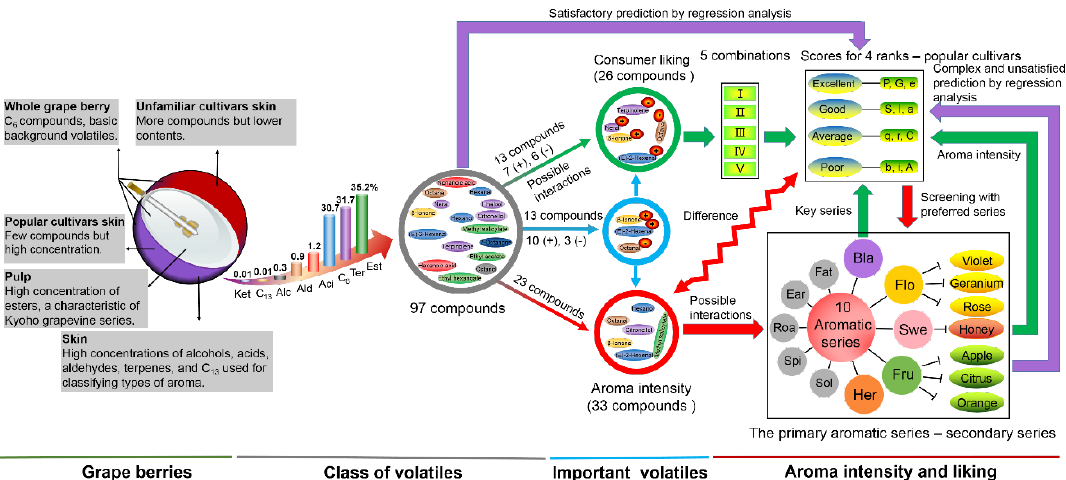
Figure 7. Schematic diagram showing the overall aroma characteristics of table grapes from a chemical perspective. The chemical types and primary aromatic series are represented by the first three letters of their names. Column heights indicate the average content of each chemical type, and for convenient viewing, the column heights of five volatiles (alcohols, acids, aldehydes, ketones, and C 13 -norisoprenoids) are amplified ten times their original height.